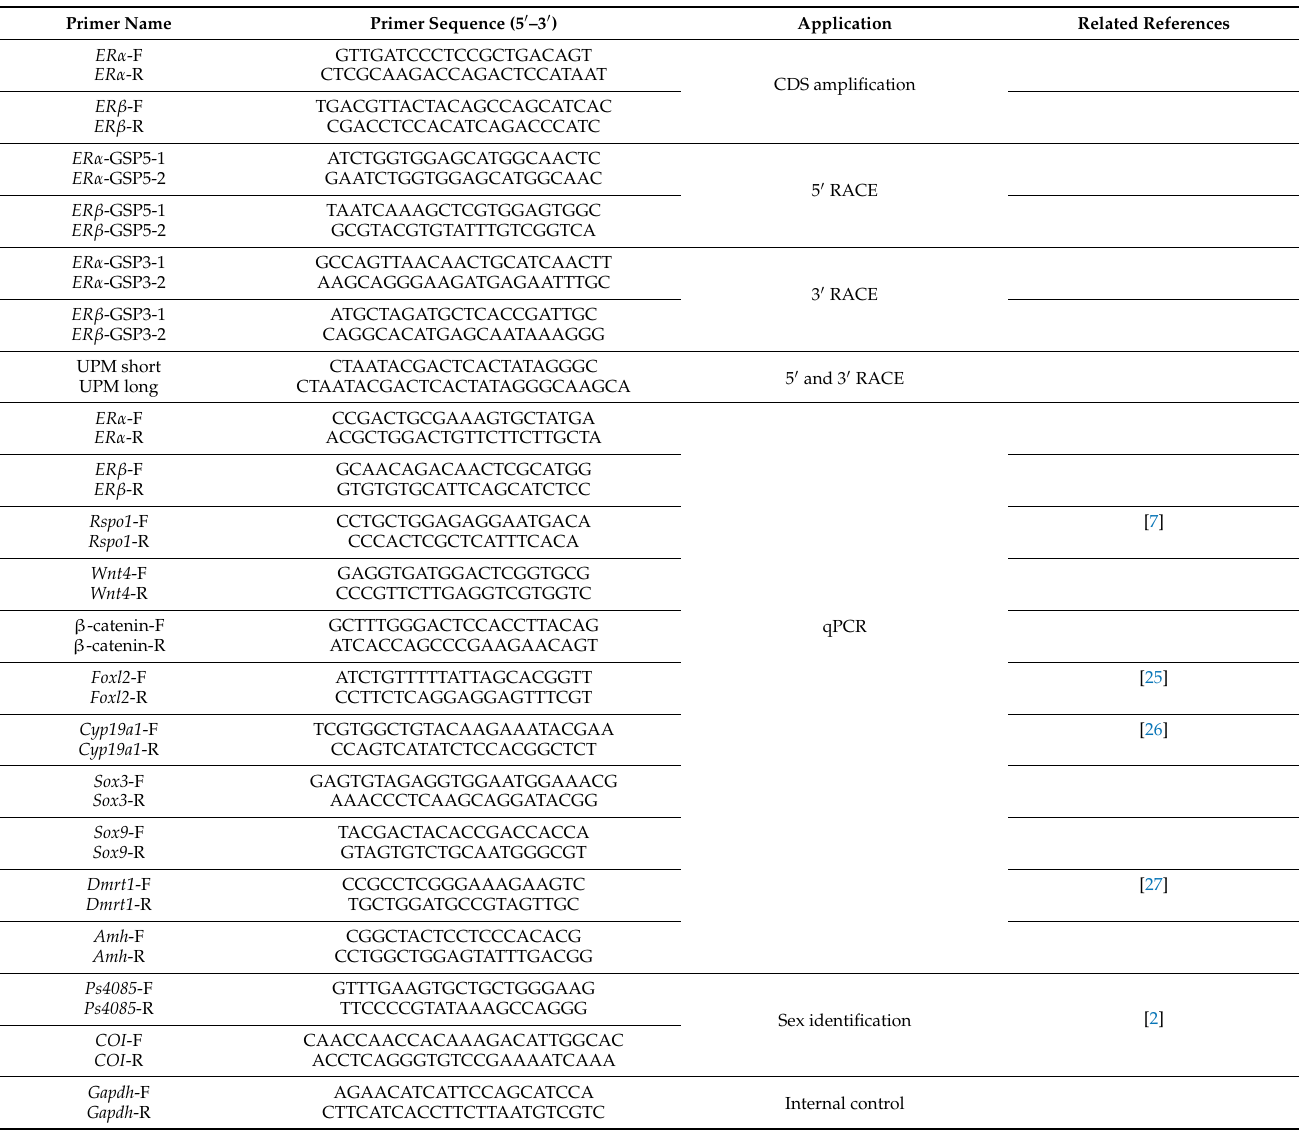
Table 1. Primers are used for